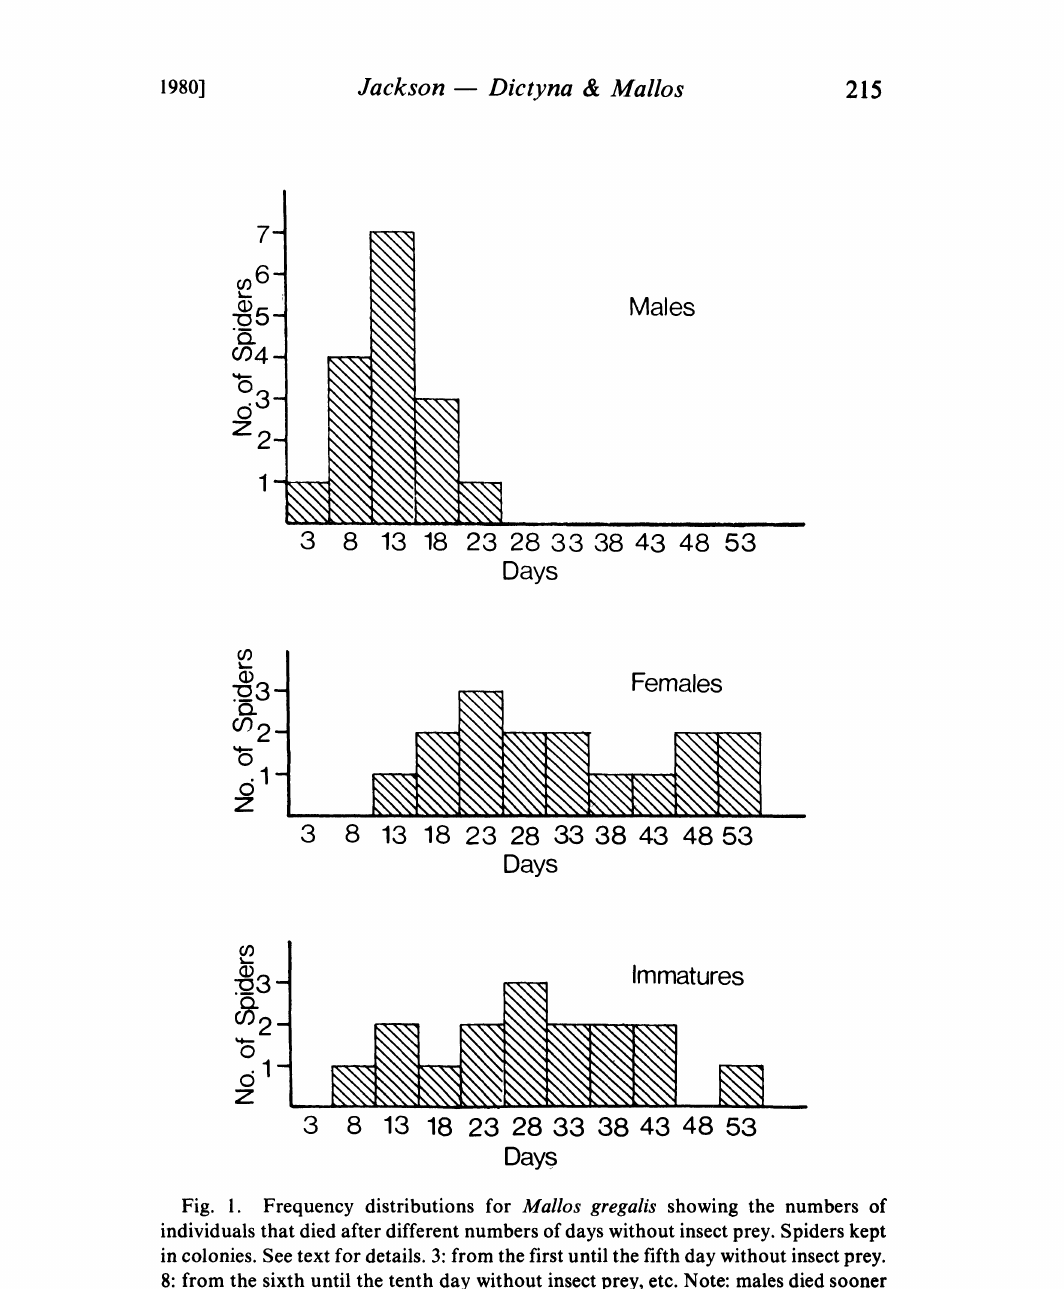
Fig. 1. Frequency distributions for Mallos gregalis showing the numbers of individuals that died after different numbers of days without insect prey. Spiders kept in colonies. See text for details. 3: from the first until the fifth day without insect prey. 8: from the sixth until the tenth day without insect prey, etc. Note: males died sooner than females and